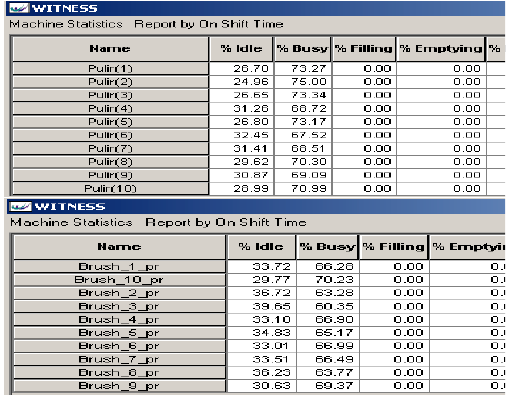
Fig. 7. Comparing of results